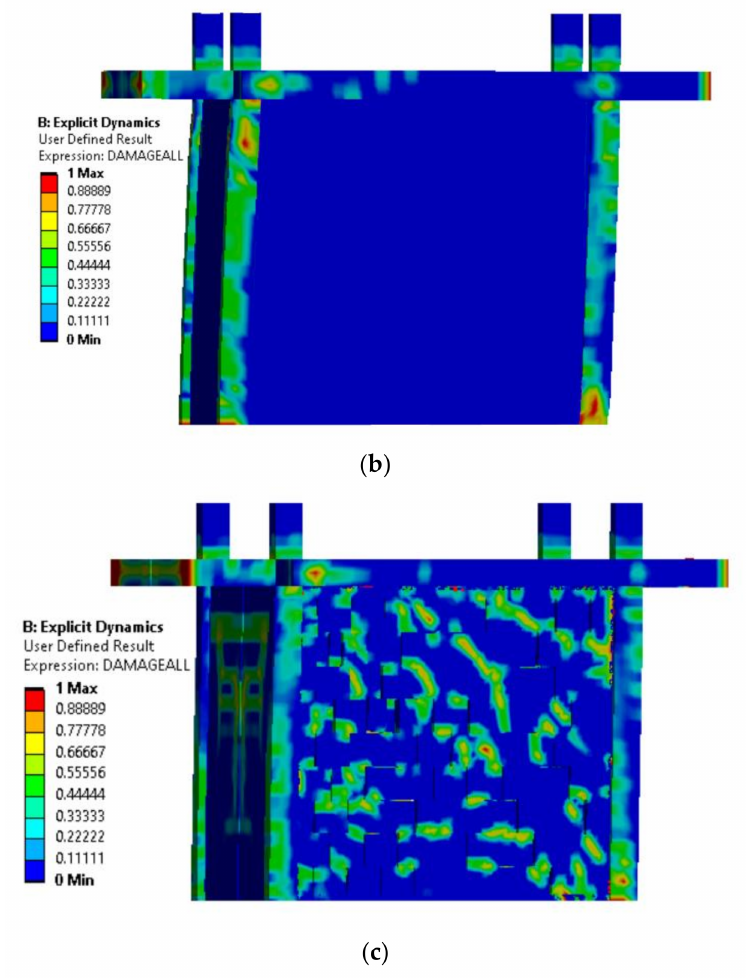
Figure 6. ( a ) Mesh of the RC structure, of the damaged brick infill and of the external FRPU retrofit; ( b ) model 2 at the end of PHASE 1; and ( c ) model 3 at the end of PHASE